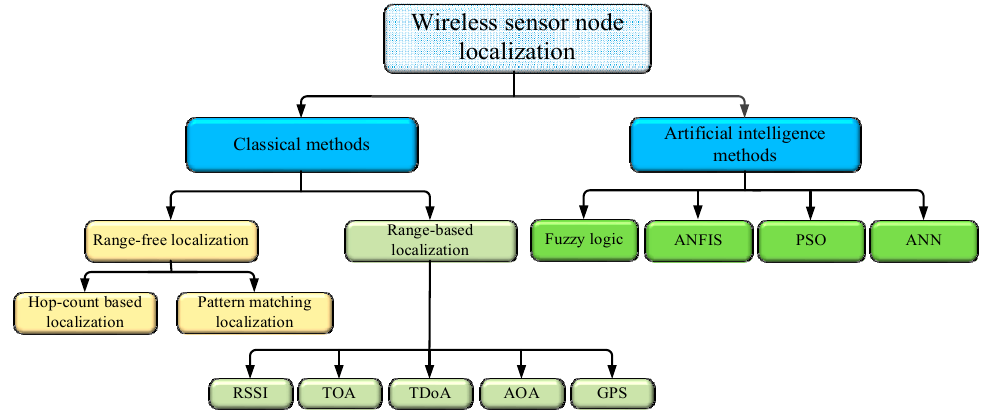
Figure 1. Classification of localization techniques.